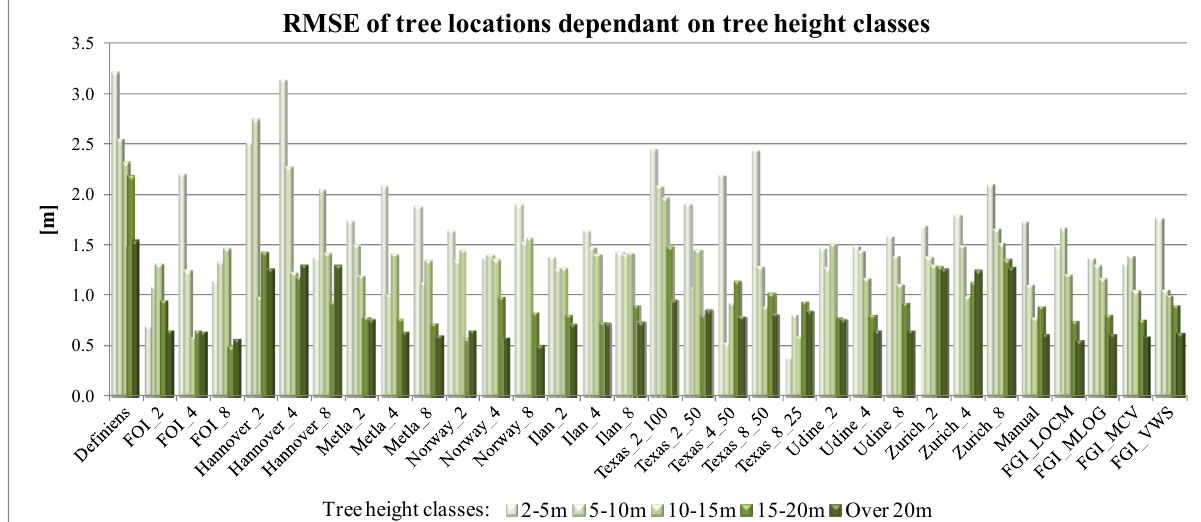
Figure 8. Accuracy of tree locations dependant on tree height